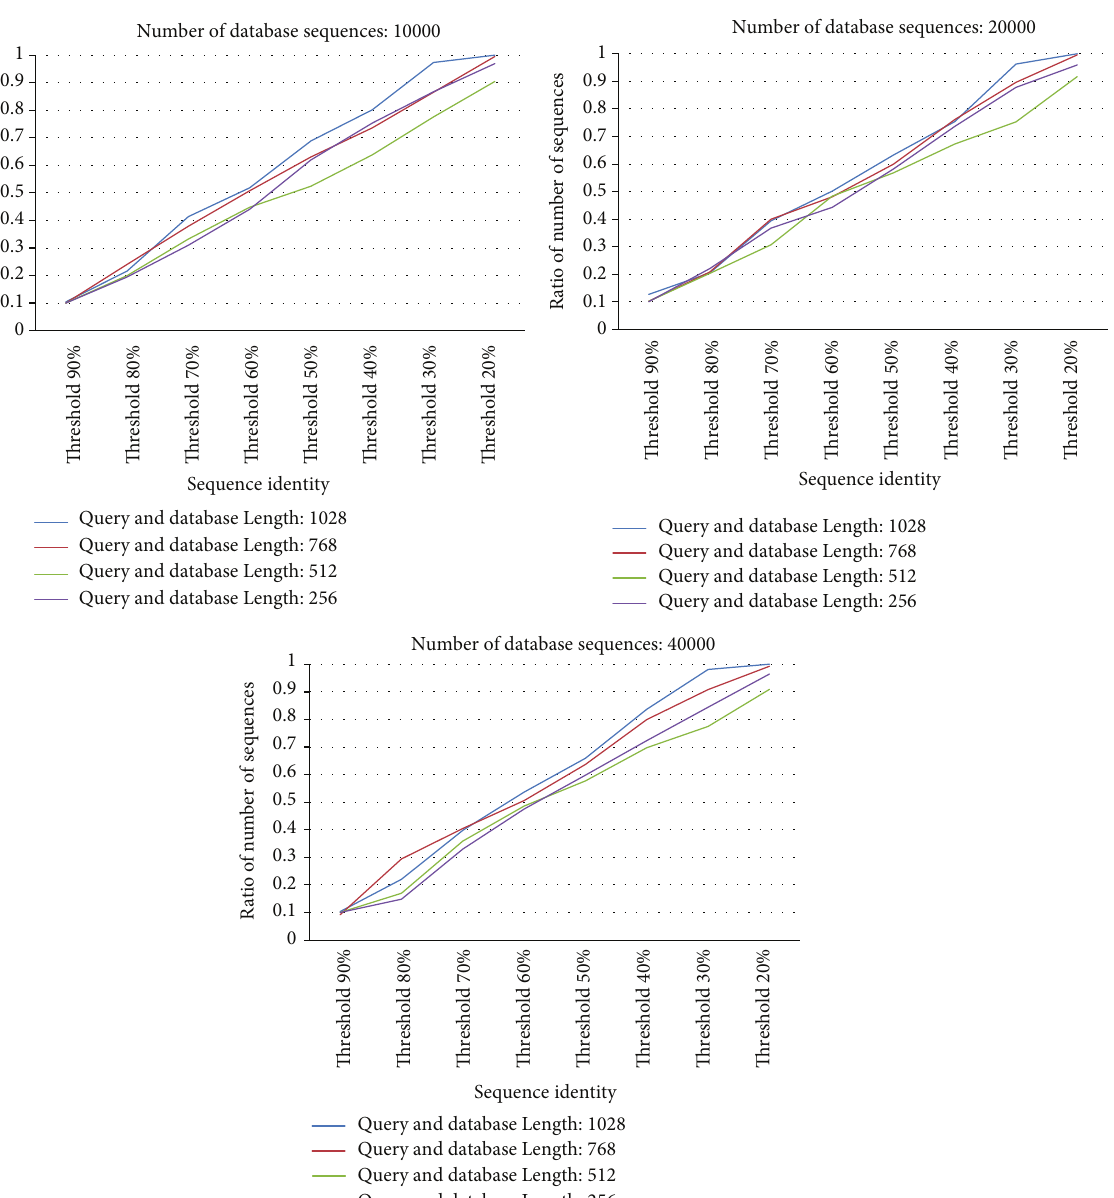
Figure 4: Ratio (%, number of selected database sequences/number of original database sequences) for 12 synthetic databases with various